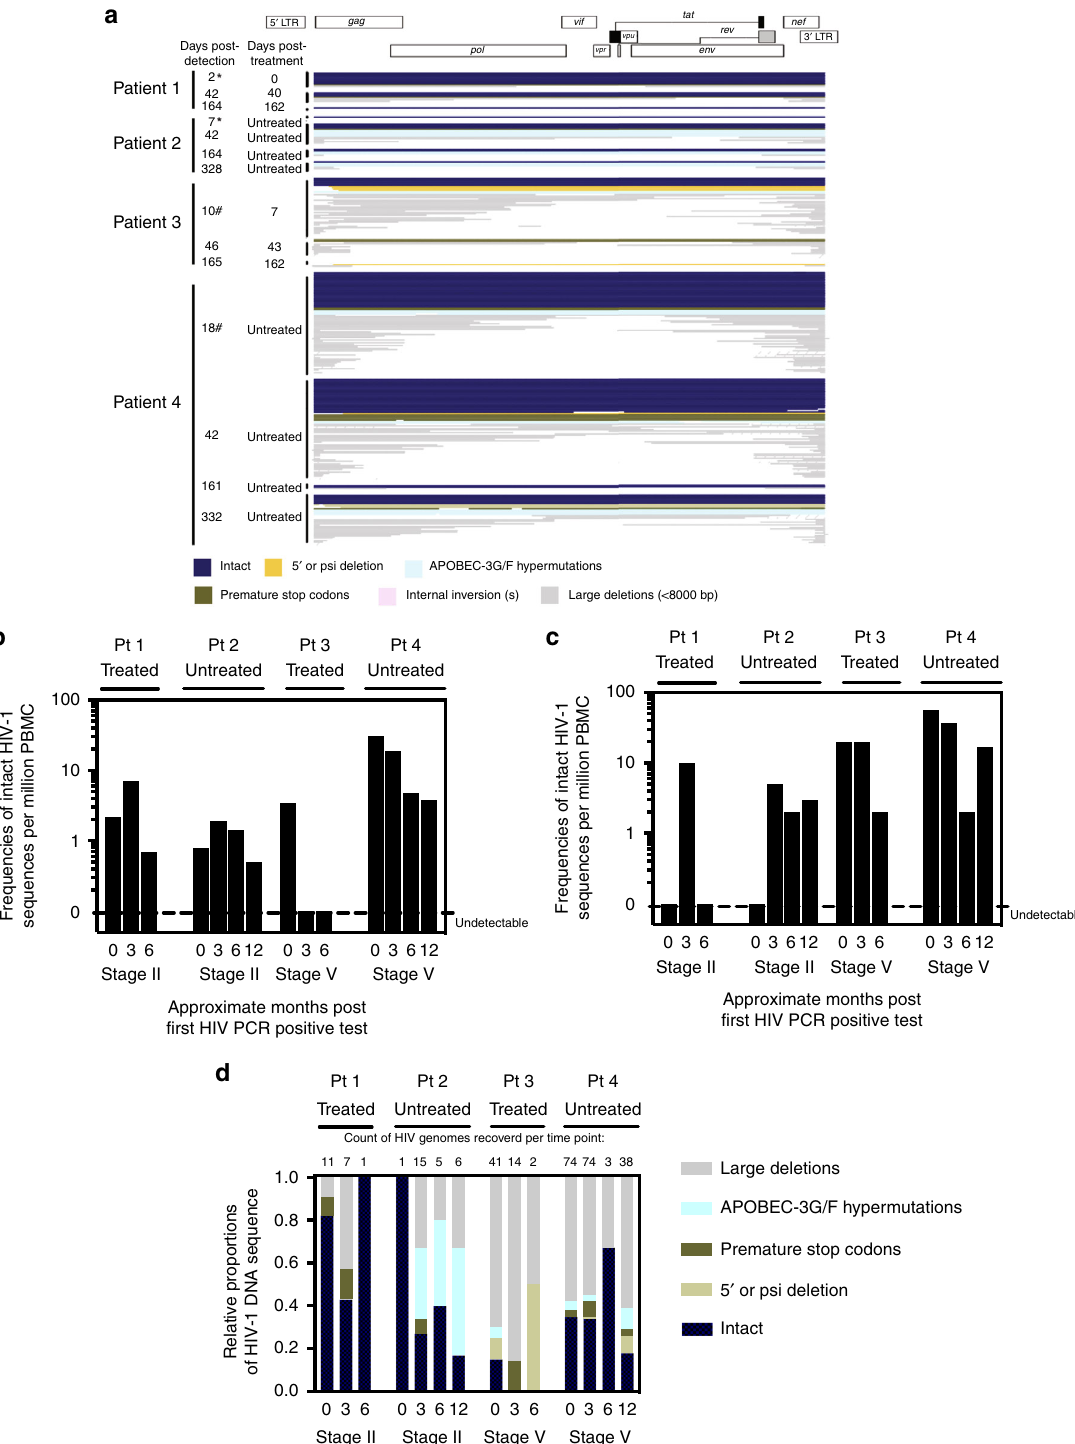
Fig. 4 Longitudinal changes in HIV-1 DNA genotypic compositions. a Diagram re fl ecting a cross-sectional view of all 292 HIV-1 genomes presented in this study from all four patients over all sampling time points (each horizontal line represents one viral genome). Navy blue lines represent intact HIV-1 genomes; other colors represent defective HIV genomes. Asterisk denotes sampling time points at stage II. Hash denotes sampling time points at stage V. b Absolute frequencies of intact HIV-1 DNA sequences per million PBMCs during the 1st year of infection. c Absolute frequencies of defective HIV-1 DNA sequences per million PBMCs during the 1st year of infection. d Relative proportions of HIV-1 DNA sequences during the 1st year of